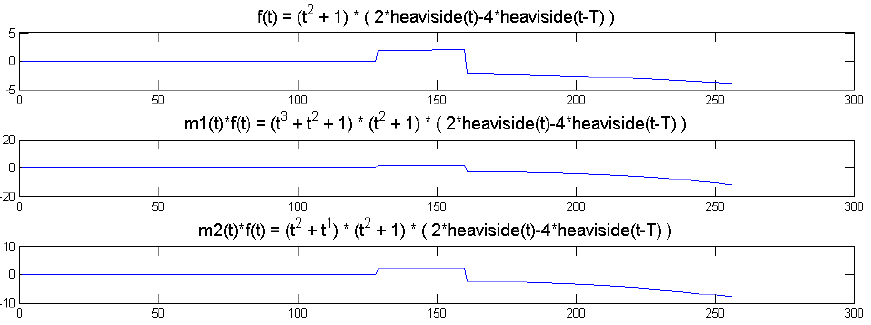
Figure 7. Daubechies wavelets of order 16 is used and the decomposition scale is